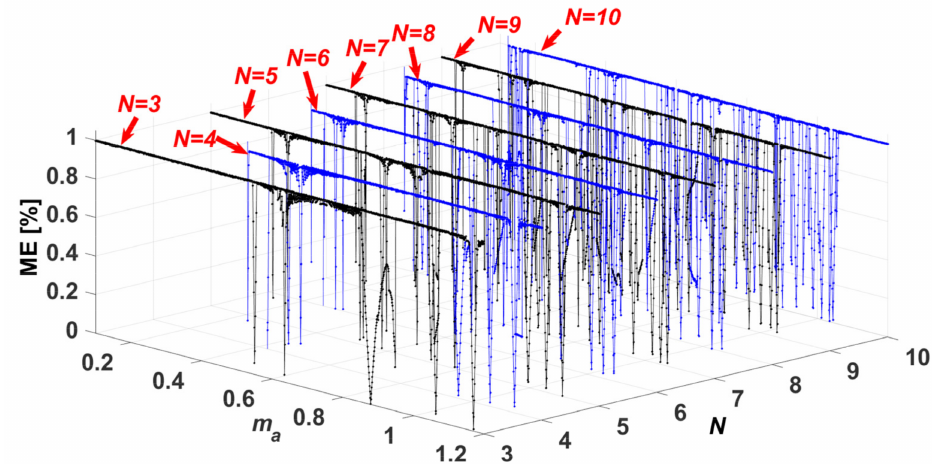
Figure 6. Calculated ME results for optimal LTHD vs. modulation index for various values of N